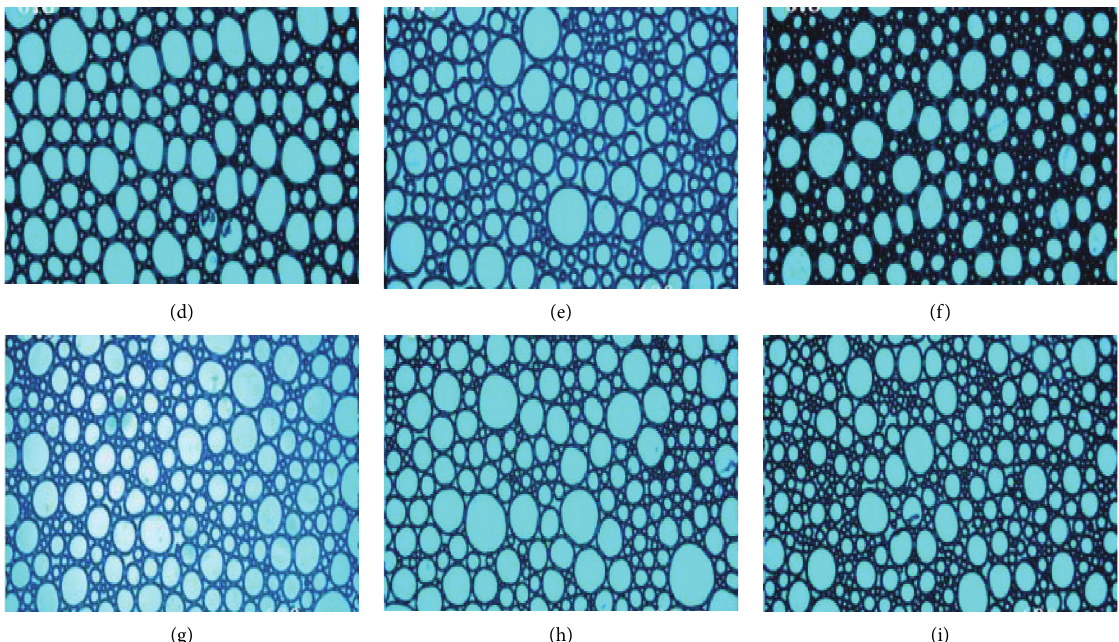
Figure 10: Microstructure of the foam under different xanthan gum concentrations: (a) 0.1; (b) 0.3; (c) 0.5; (d) 0.6; (e) 0.7; (f) 0.8; (g) 0.9; (h) 1.0; (i) 1.1.